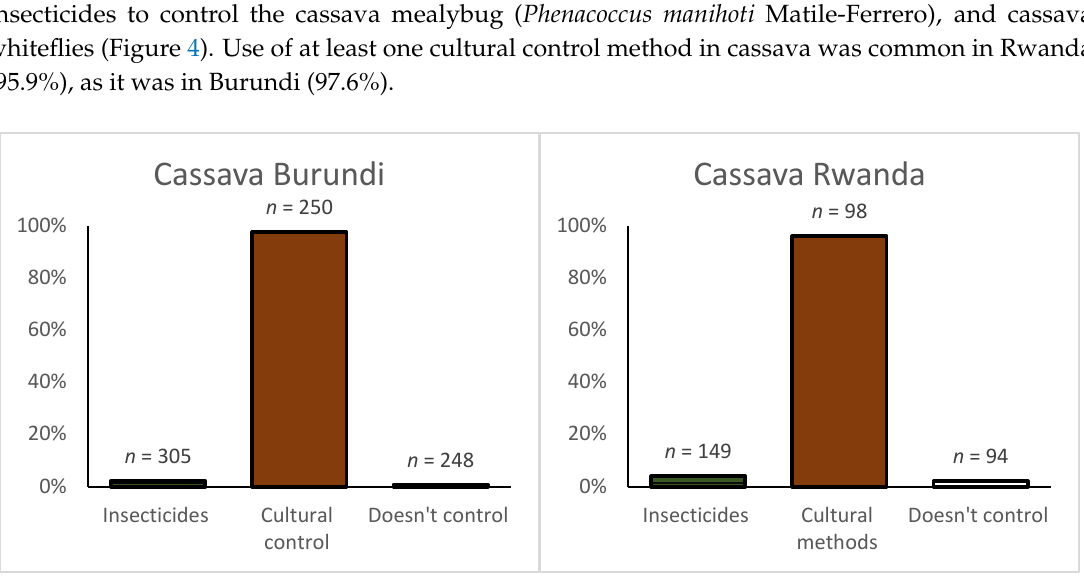
Figure 4. Pest and disease management practices used in cassava in Rwanda and Burundi. Multiple responses were possible. n = number of responses.